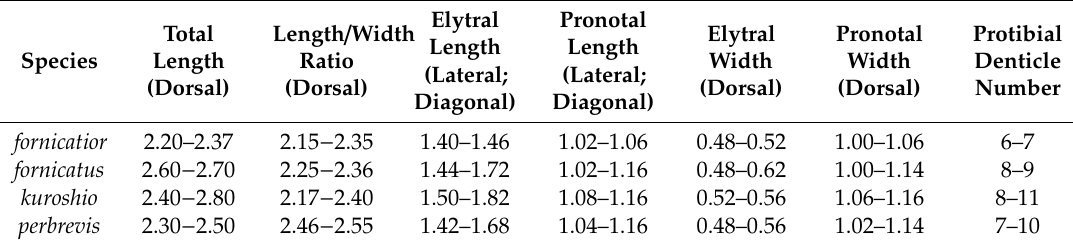
Figure 2. Classification tree from the classification and regression tree (CART) analysis built on 65 individuals representing the four species within the E. fornicatus complex. The relevant characters for the node splits are shown. The classification rates are expressed as the number of correct classifications divided by the number of observations (individual beetles) in the node for the individuals used to train the CART model. Table 2. Comparative table of measurements (mm) for Euwallacea fornicatior , E. fornicatus , E. kuroshio , and E. perbrevis . Measurements for the total length, pronotal and elytral width, and length / width ratios are measured in the dorsal view, while the pronotal and elytral length are measured in a lateral view on a diagonal, as detailed by Gomez et al. [14].